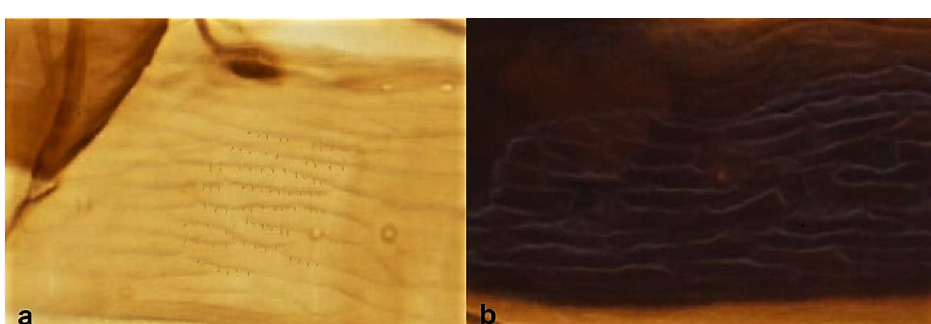
Fore wing evenly brown, not banded (Figure 13b) and with a small pale sub-basal